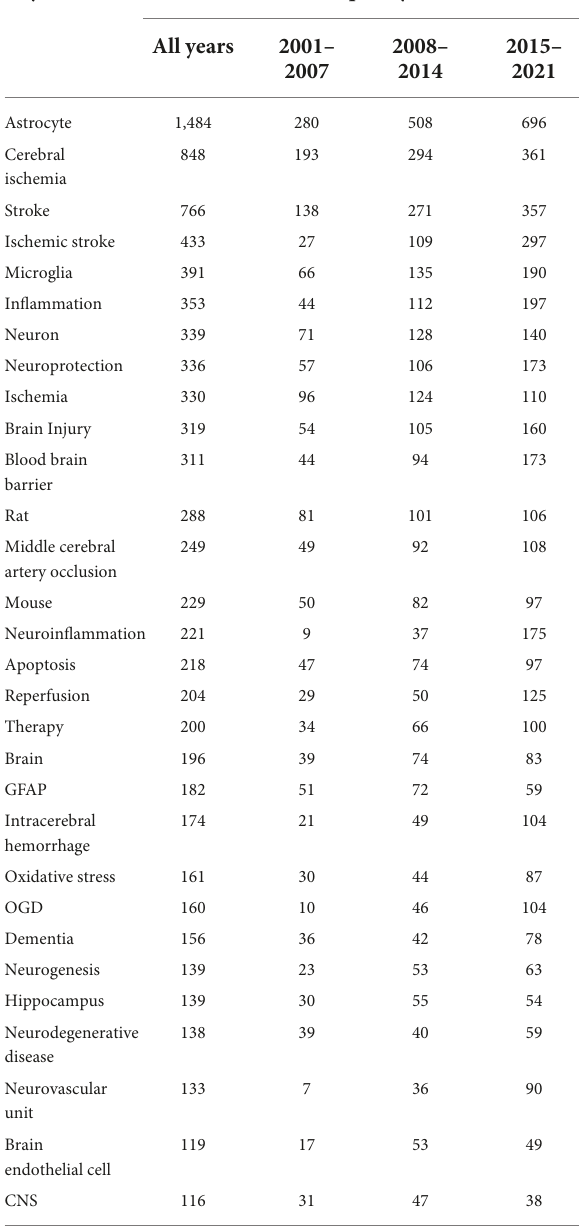
TABLE 5 Frequency of top 30 most used author keywords in each